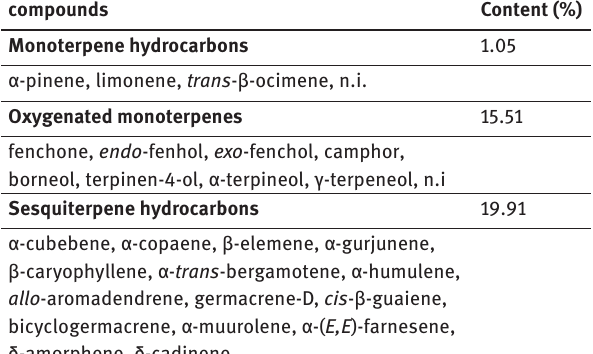
Table 1: Chemical composition of TrEO. compounds Content